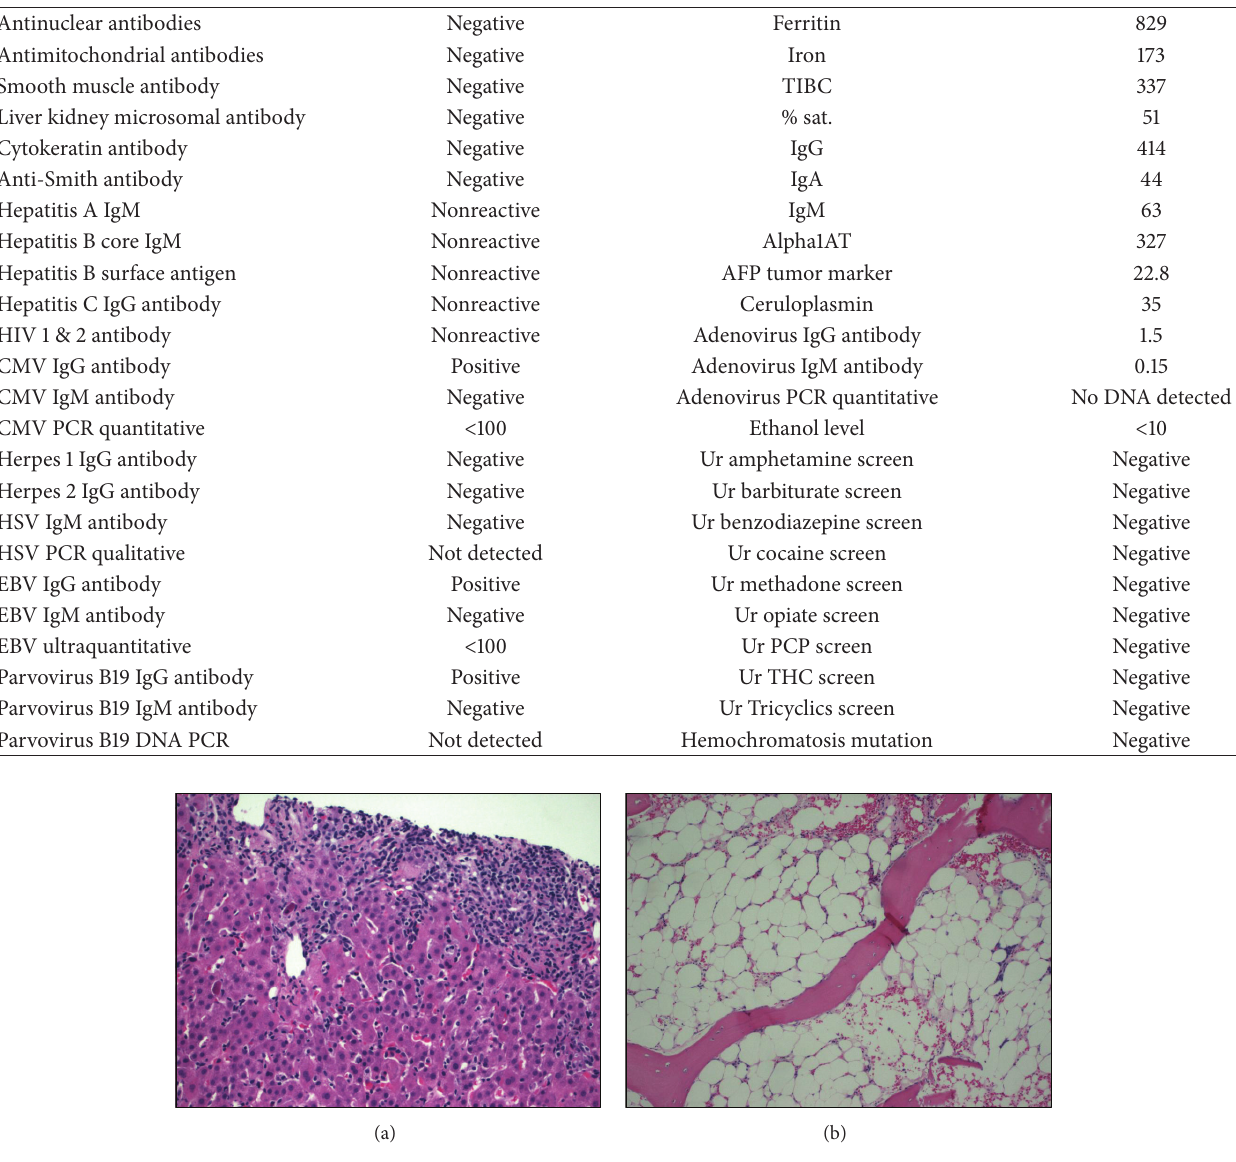
Figure 1: (a) Liver biopsy demonstrating features of active hepatitis, impressive inflammatory process involving both portal areas, and the lobules displaying also a pattern of sinusoidal lymphocytosis. (b) Bone marrow biopsy showing severe marrow